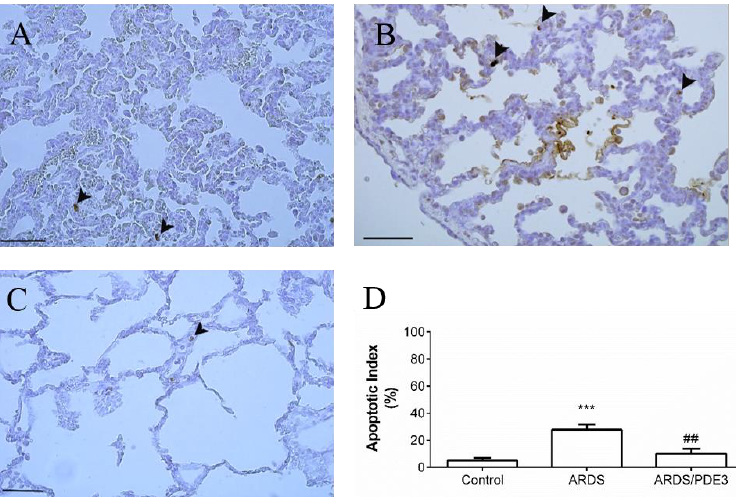
Figure 3. Apoptosis of lung epithelial cells visualized by TUNEL methods after the 4h therapy. Representative microphotographs of the lungs of healthy controls ( A ); animals with non-treated ARDS ( B ) and animals with ARDS treated with olprinone ( C ) using the TUNEL method for detection of apoptosis , scale bars: 50 μm . ( D ) Relative values of the apoptotic index. Arrowheads indicate a higher number of apoptotic (dark brown) nuclei of epithelial cells in the alveoli (A), (B). After treatment with olprinone, a decreased number of apoptotic alveolar cells was found (C). Statistical comparisons: for ARDS vs. Control *** p < 0.001; for ARDS/PDE3 vs. ARDS ## p < 0.01. Data are presented as means ± SEM.